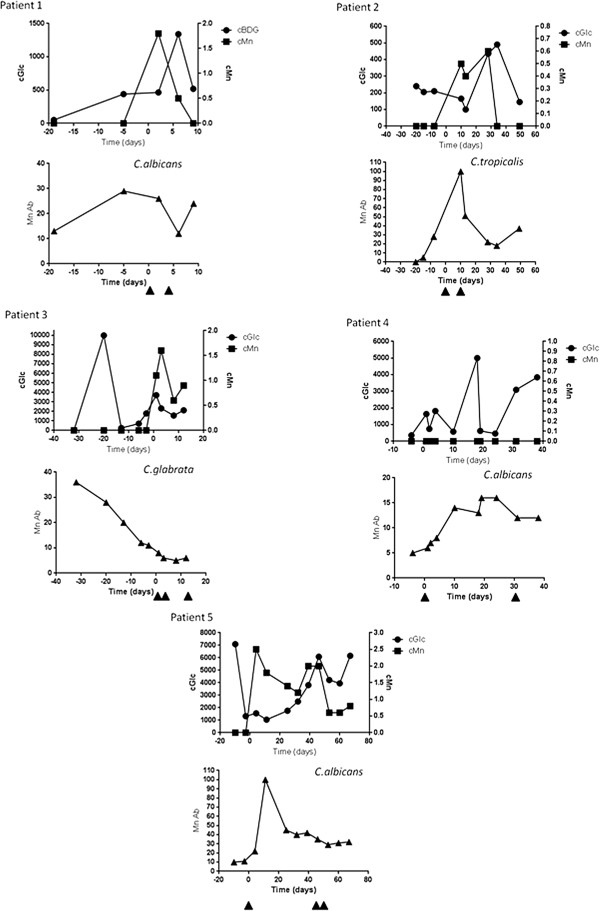
Kinetics of β-d-1,3-glucan, mannan and mannan antibody in five patients with candidaemia relapses. The dates of subsequent Candida isolations from blood are indicated by arrows. All patients, except Patient 4 with no detectable mannan, had values above the cutoff point for all tests, but with different kinetics. β-d-1,3-glucan (BDG) and mannan presented different kinetics of circulation in a single patient. The well-known transient nature of circulating mannan was observed and correlated with an inverse evolution of mannan antibody (Patients 1, 2, 3 and 5). Interestingly a sharp decrease in BDG was also observed over a short period of time (Patients 3, 4 and 5). cGLC/cBDG, concentration of BDG; cMn, concentration of mannan; Mn Ab, concentration of mannan antibody.